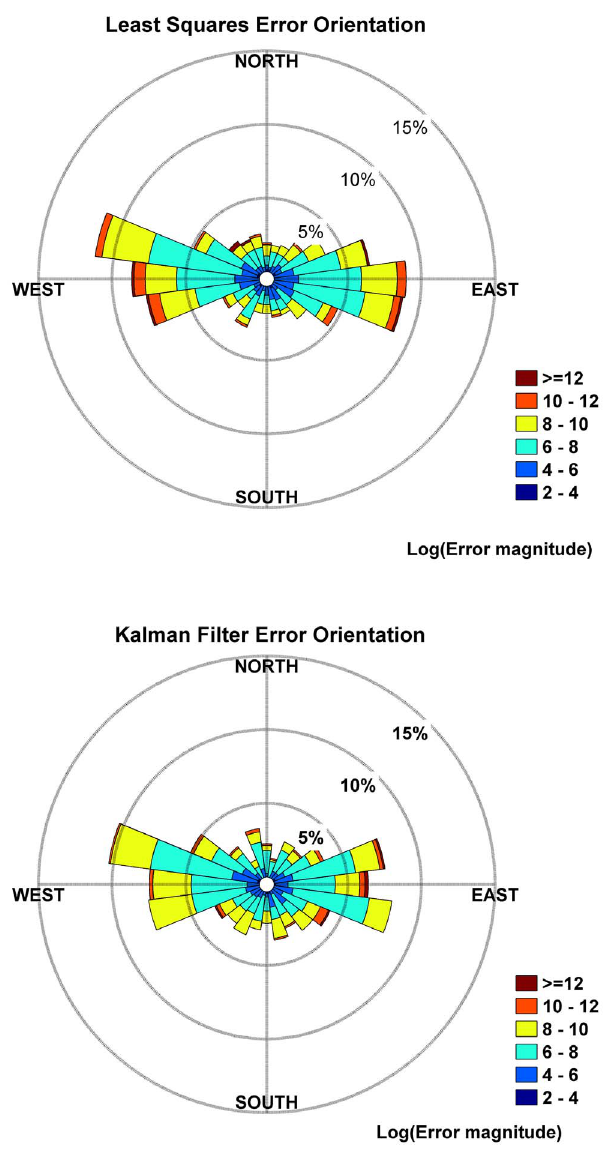
Figure 1. Radial histograms of the error orientations. Histograms are for all location codes combined; histograms are somewhat different for different location codes but give the same qualitative results. E-W errors predominate over and tend to be larger than N-S errors for both processing methods.